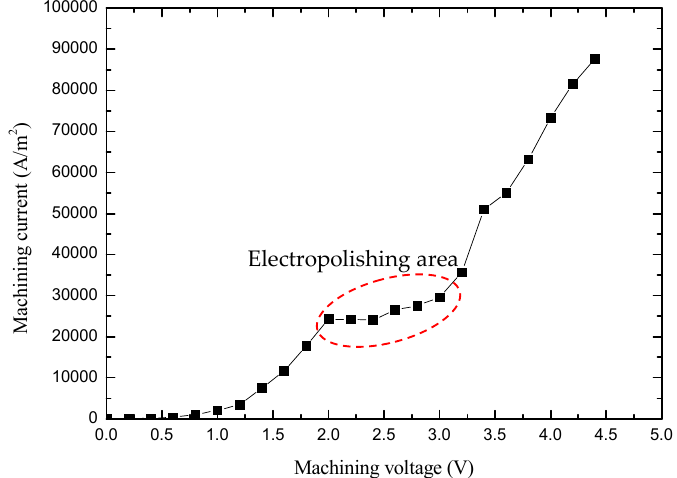
Figure 7. The voltage-current density relation curve.